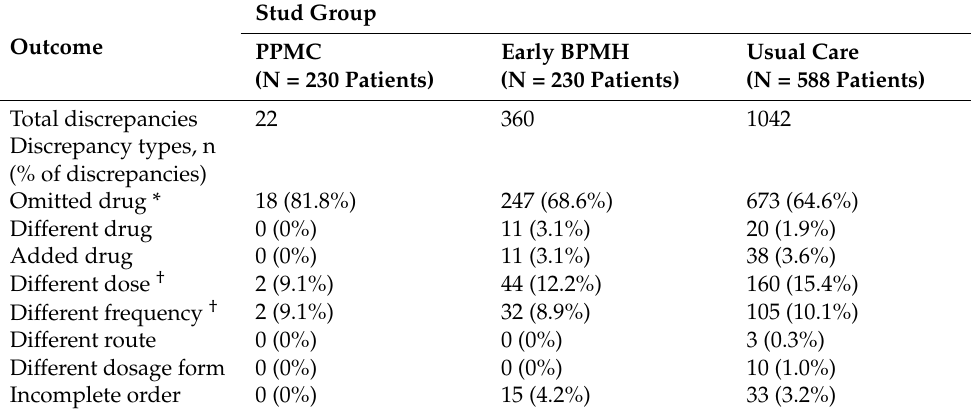
Table 2. Types of undocumented medication discrepancies.